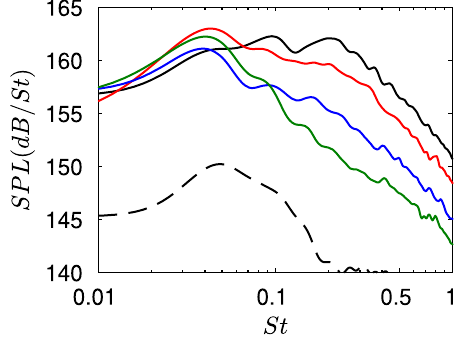
Figure 6. Sound pressure levels (SPL) at z = 0 and r = 2 r 0 as a function of the Strouhal number St for L = 15 r 0 , L = 20 r L = 25 r L = 30 r 0 , 0 and 0 and the free jet